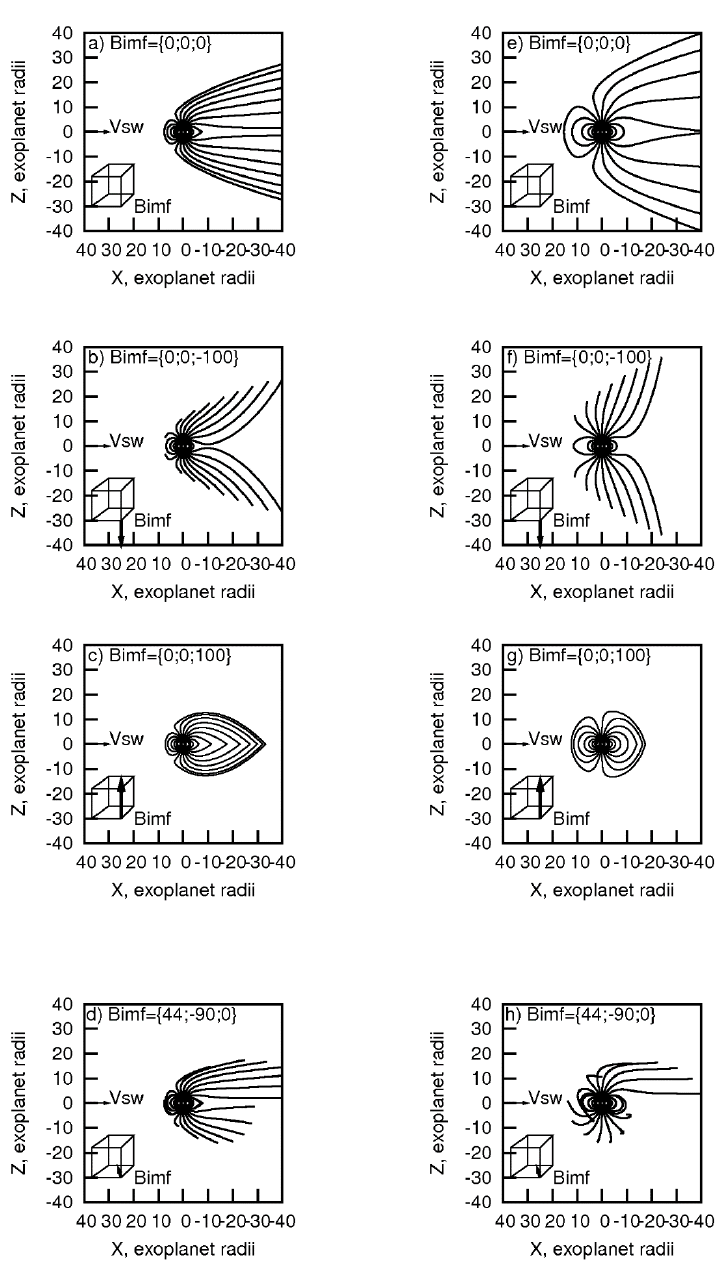
Figure 2. The figure shows variations of magnetospheric magnetic field structure for rmp = 8 Rpl, R2 = 5.6 Rpl, Bt = 121 nT (left column; subfigures ( a – d )) and rmp = 16 Rpl, R2 = 11.2 Rpl, Bt = 15 nT (right column; subfigures ( e – h )) for different orientations of the stellar wind magnetic field (IMF). The components of the IMF are given for each image. The coefficient of IMF penetration k = 0.2. Magnetic field lines projected on the plane XZ are plotted. Vector V sw marks the average stellar wind velocity.